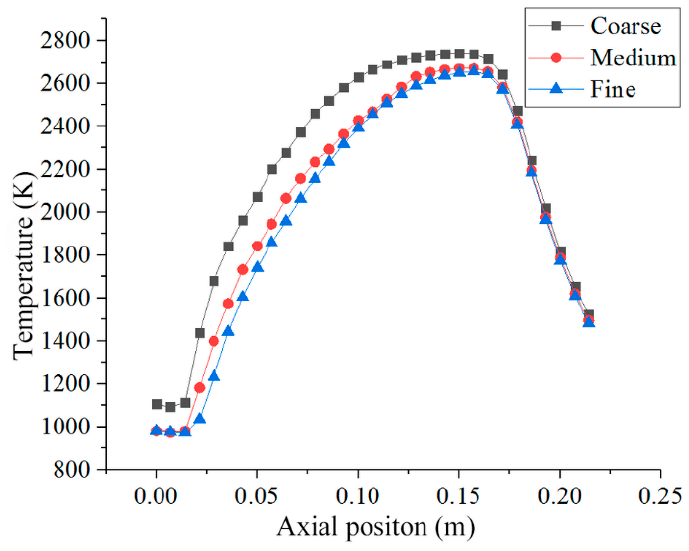
Figure 8. Variation in temperature with different numbers of meshes.